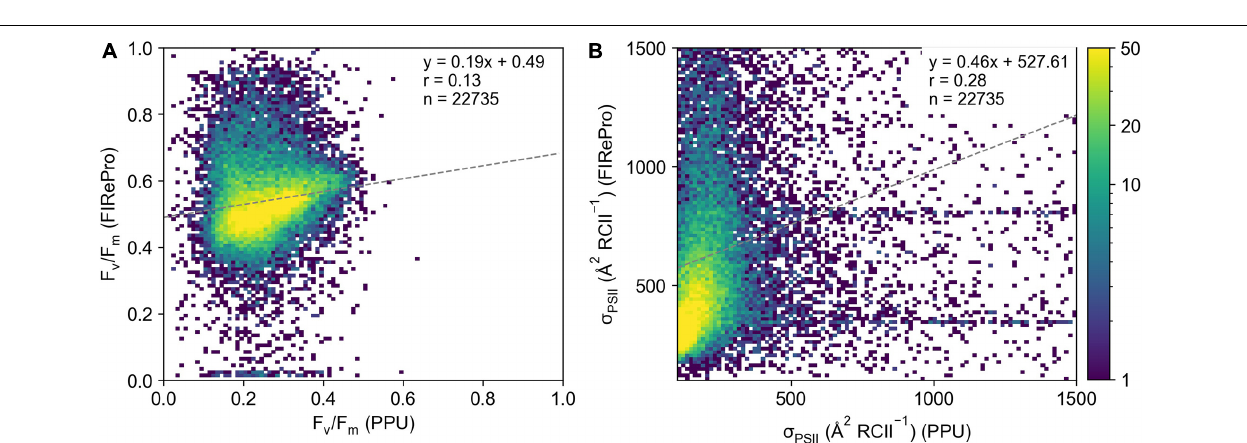
Frontiers in Marine Science |